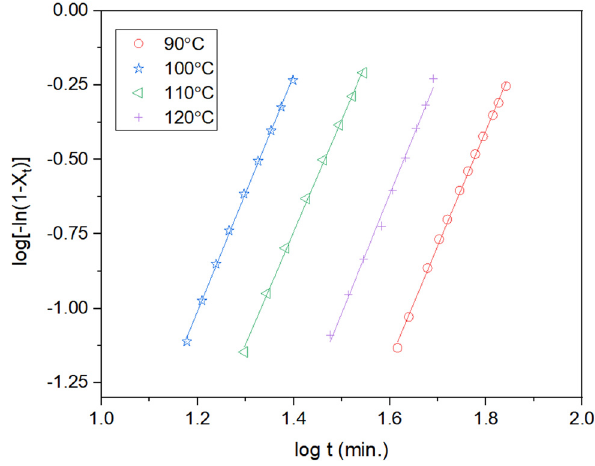
Figure 8: Plots of log [ − ln ( 1 − X t )] vs log ( t ) for isothermal crystallization.